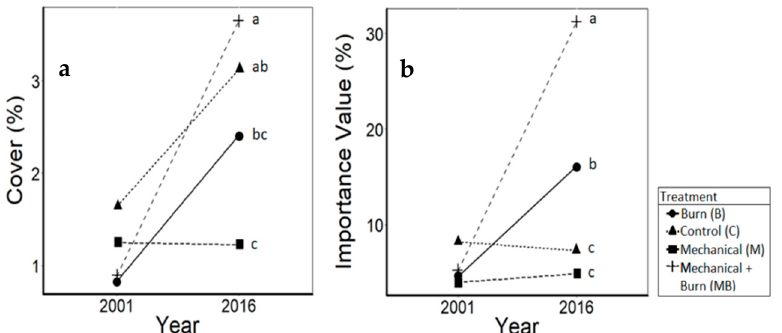
Figure 9. Graminoid primary guild ( a ) absolute cover (%) and ( b ) importance value results showing the 4 treatment e ff ects (control = C, burned = B, mechanical removal of stems < 10 cm in diameter at breast height (DBH) = M, and mechanical removal of stems < 10 cm DBH + burned = MB) from 3 analysis of variance (ANOVA). Post-hoc comparison (Tukey’s Honest Significant Di ff erence Test, THSD) letters show di ff erences between treatment e ff ects from 2001 to 2016.